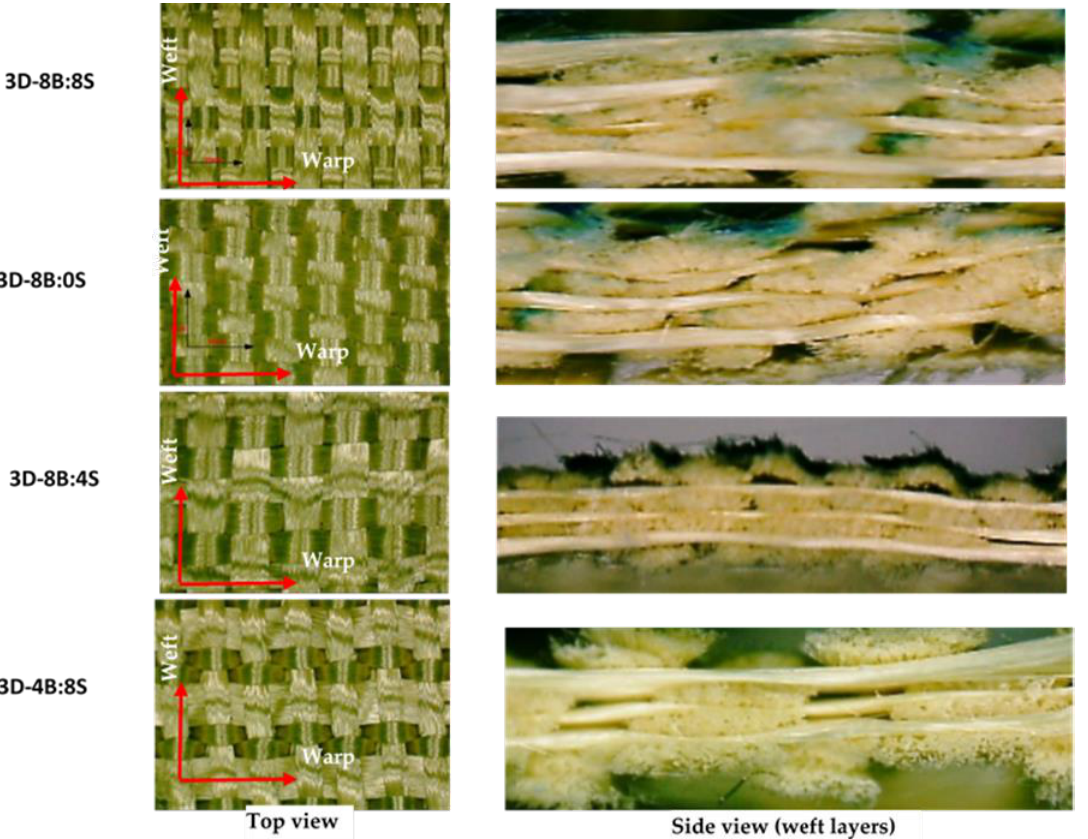
Figure 2. Differently manufactured 3D warp interlock fabrics in top and side (five weft layer) view. Table 1. Specification of high-performance para-aramid fiber and the produced 3D warp interlock